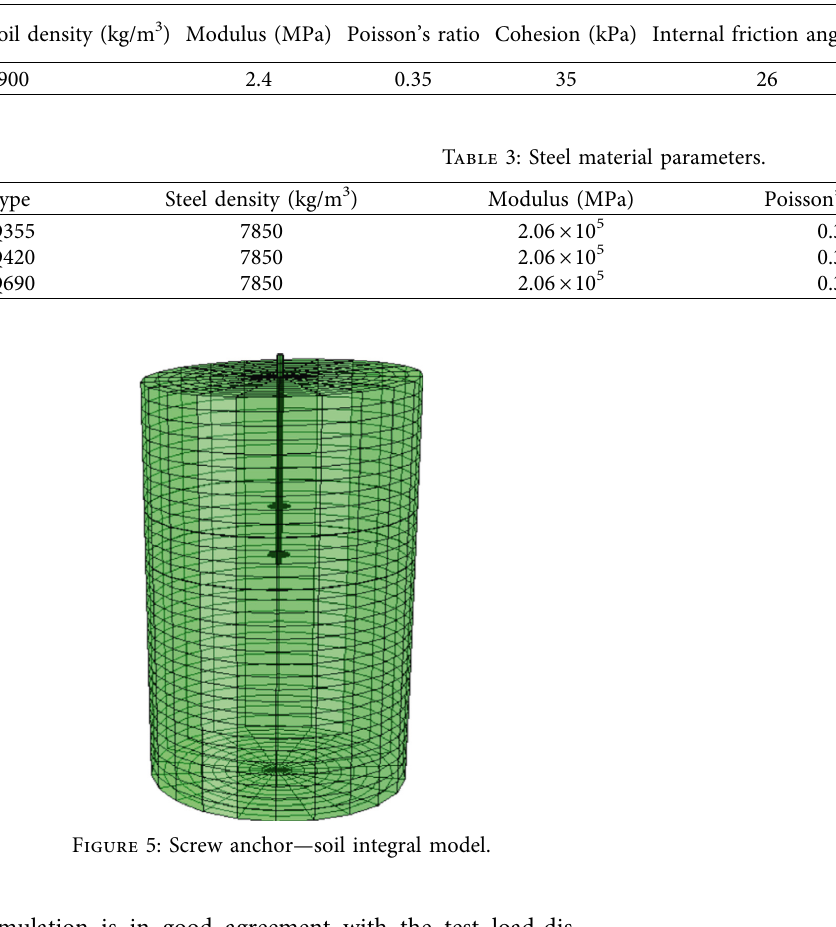
Table 2: Material properties of the soil.